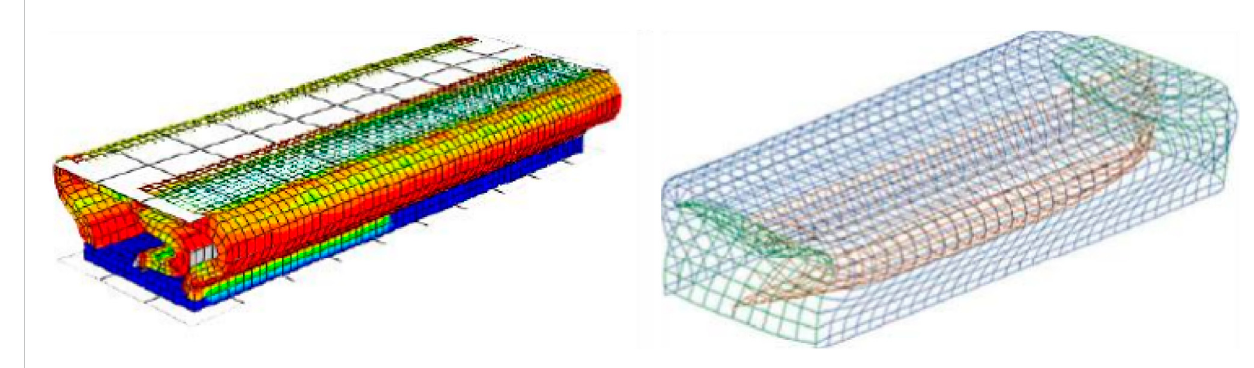
FIGURE 8 Simulation using ABAQUS and reference (Jiang et al., 2010).